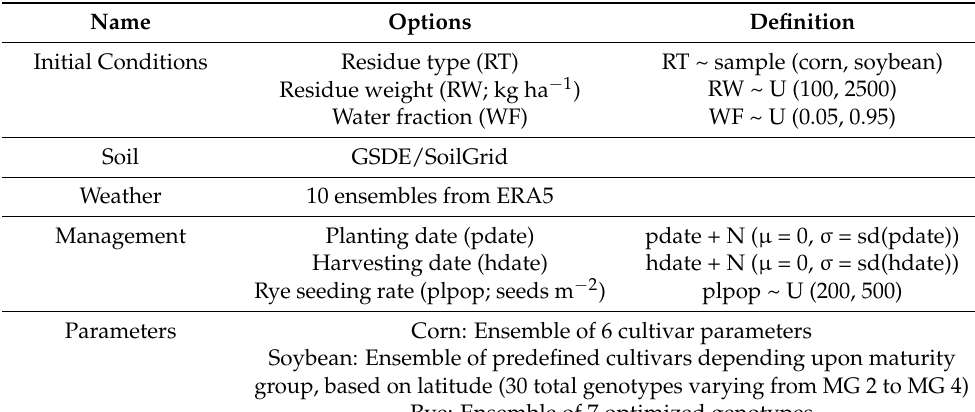
Table 1. Uncertainty factors considered for simulating each scenario in long term simulations. U stands for uniform distribution, and N stands for normal